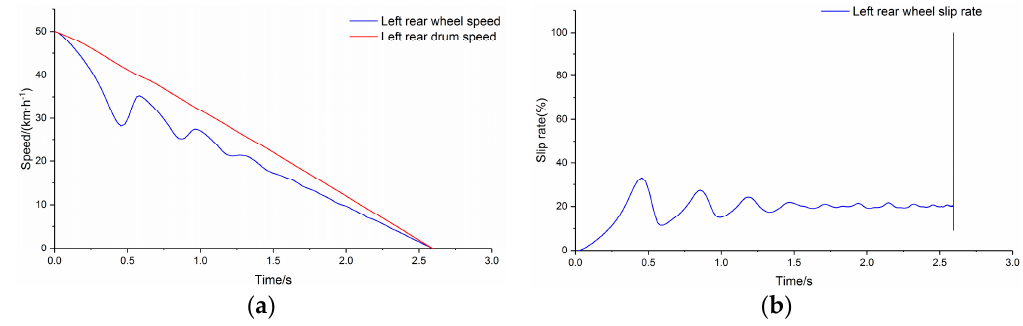
Figure 10. ( a ) Left rear comparison of main drum speed and wheel speed; ( b ) slip rate.